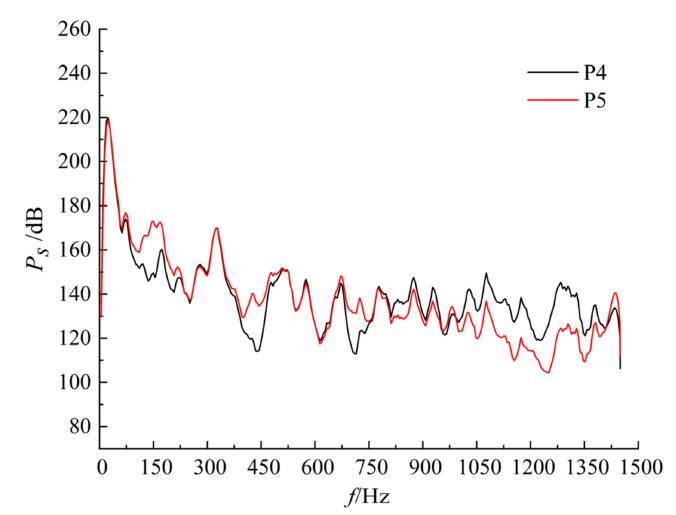
Figure 15. Spectrum diagram at monitoring points of the outlet area.